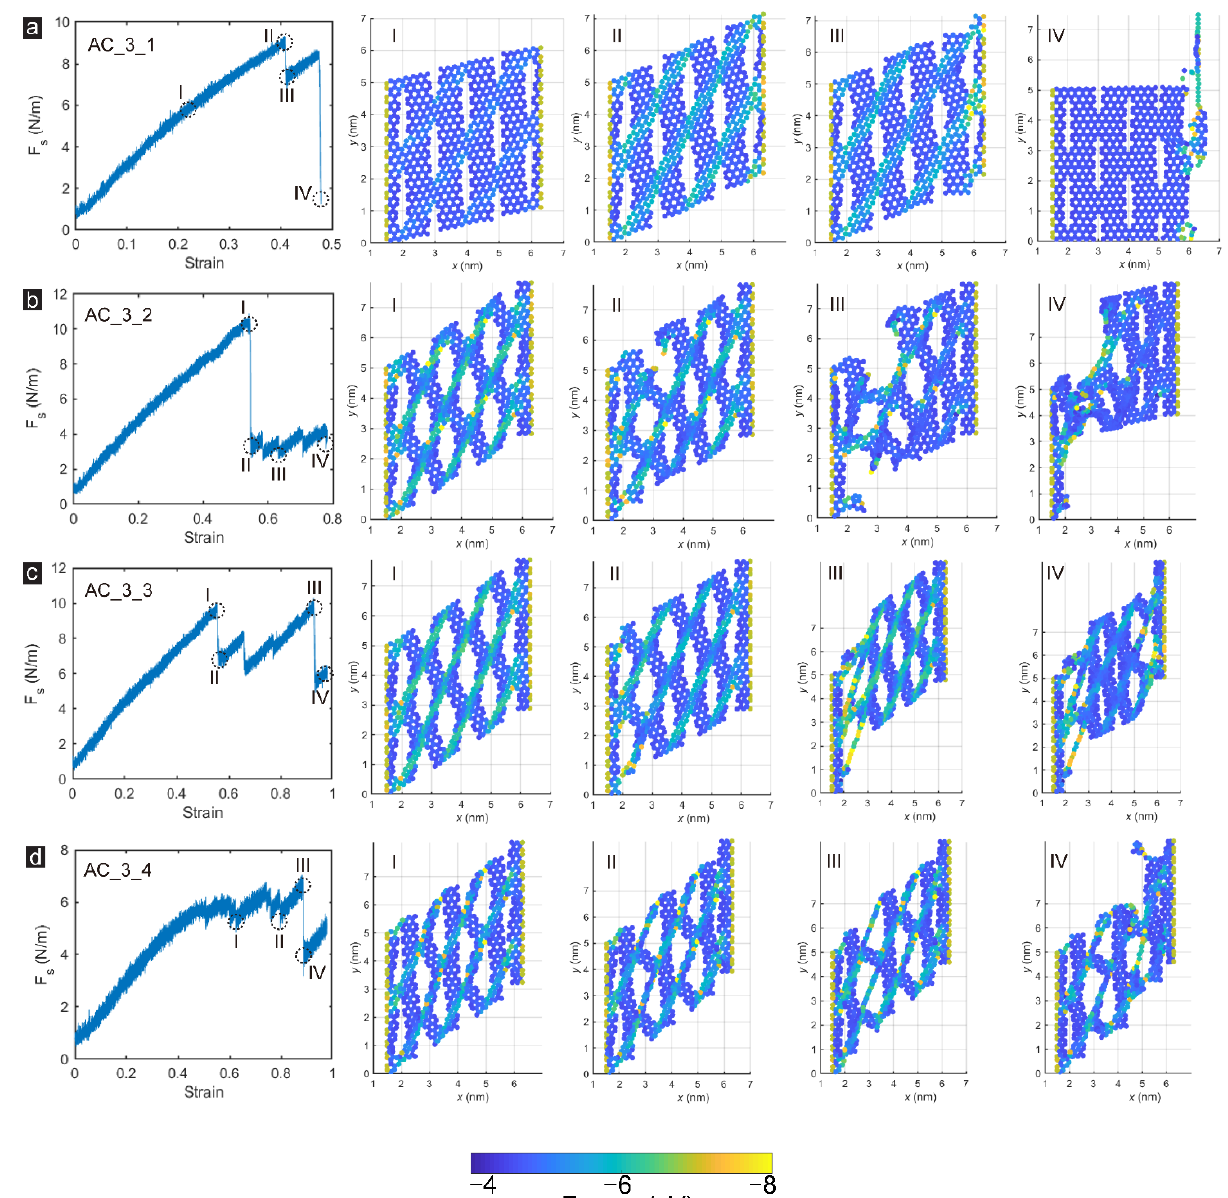
Figure 7. The snapshots of the microstructural damage processes and failure characteristics of armchair-incised GK membrane: Sample ( a ) AC_3_1; ( b ) AC_3_2; ( c ) AC_3_3 and ( d ) AC_3_4.